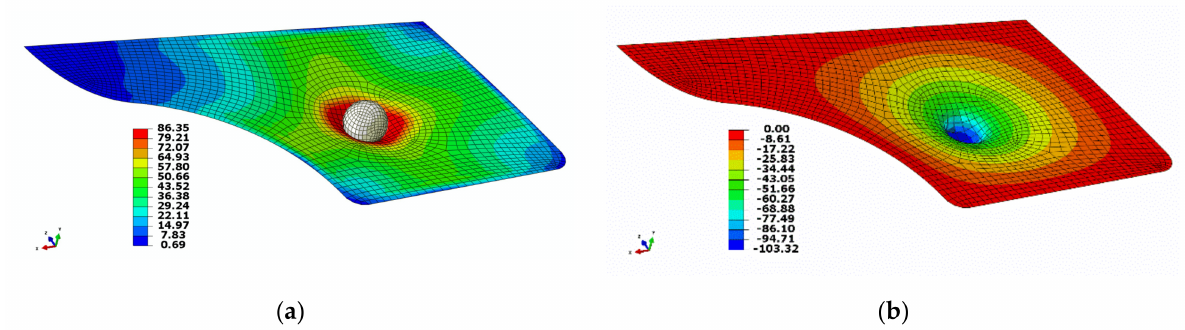
Figure 8. Deformed shape of the door interior. The color representation of ( a ) von Mises stress and ( b ) vertical